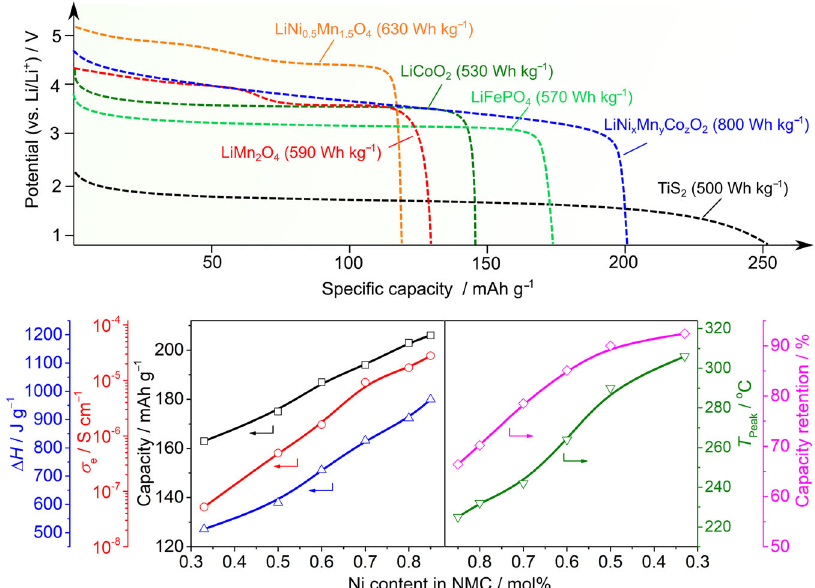
Fig. 3 Cell chemistry of typical insertion cathode materials. Upper plot Discharge pro fi les (vs. Li-metal anode) of TiS 2 , LiMn 2 O 4 , LiCoO 2 , LiFePO 4 , LiNi 0.5 Mn 1.5 O 4 and LiNi x Mn y Co z O 2 . The estimated speci fi c energy of each cathode is shown in parentheses, and the values are obtained by simply considering the working voltage of a Li metal||IC half-cell and the discharge capacity of each cathode. Lower plot Effect of the Ni amount on the discharge capacity, thermal stability (peak temperature ( T peak ) and heat generation ( Δ H )), capacity retention and electronic conductivity ( σ e ) of various NMC materials. Detailed information on these parameters is given in Supporting Table 2.